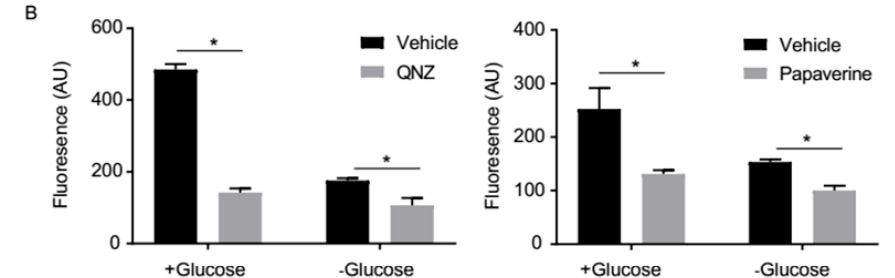
Figure 4. Acute inhibition of the mTOR pathway in tumor cells treated by papaverine and QNZ under glucose starvation. The indicated cells were treated for 3 h with papaverine (10 µ M) or QNZ (100 nM) in the presence or absence of glucose, after which cell lysates were collected and analyzed by immunoblot using the indicated antibodies. ( B ) Mitochondrial activity of DLD1 cells treated as in ( A ) was measured by TMRE (Tetramethylrhodamine, ethyl ester) and FACS (fluorescence-activated cell sorting). AU = arbitarary units. Data represents mean ± SD; * p < 0.05; n ≥ 3 independent experiments.